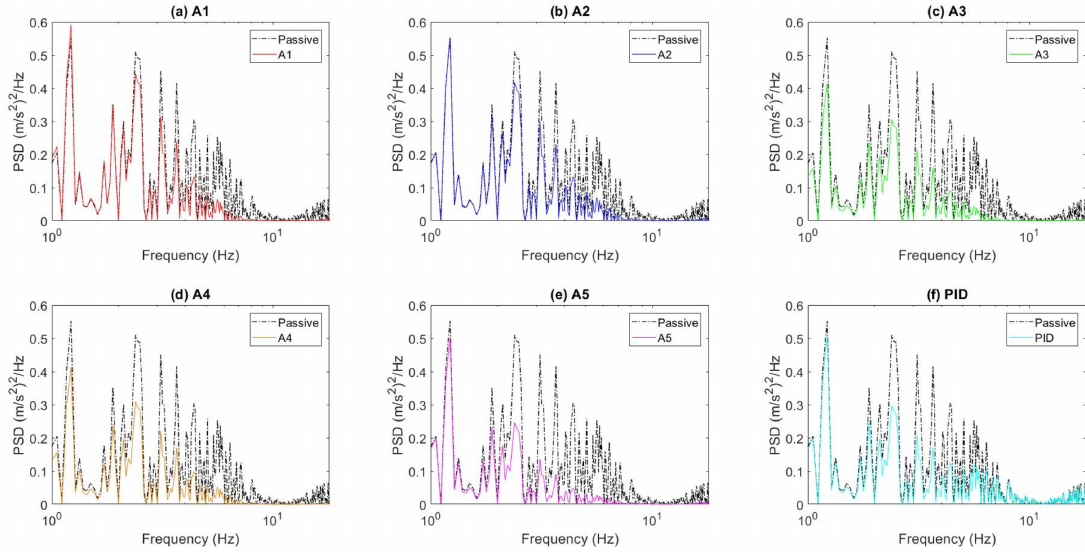
Figure 6. PSD of the seat acceleration for passive and active seat suspensions at a vehicle speed of 60 km/h. ( a ) A1; ( b ) A2; ( c ) A3; ( d ) A4; ( e ) A5; ( f )